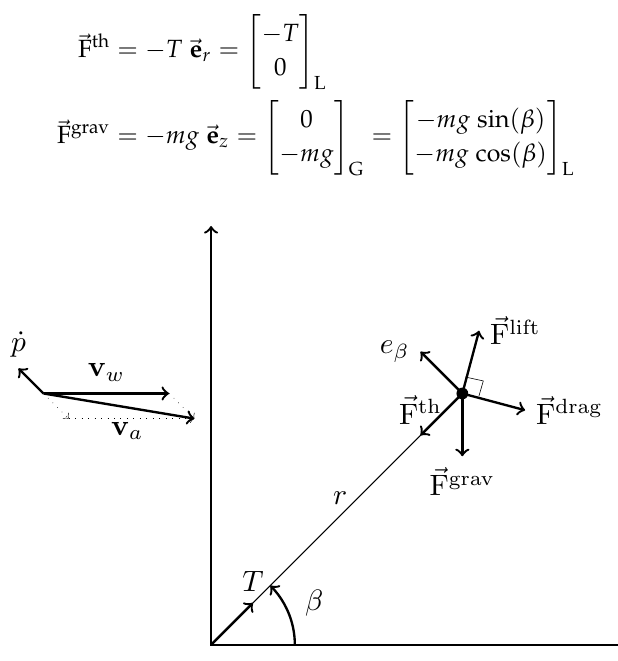
Figure 2. Forces acting on the